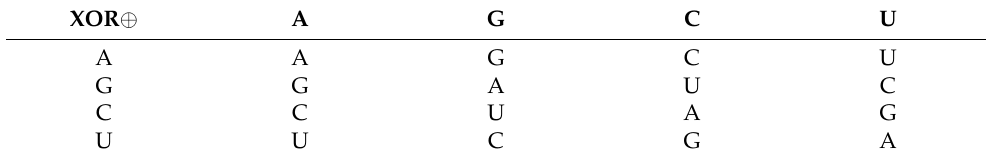
Table 7. RNA XOR rule.